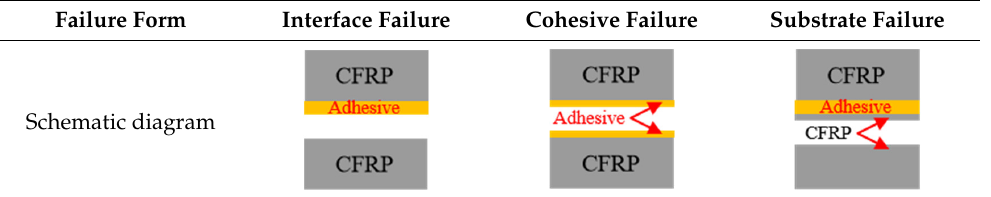
Table 7. Schematic diagram of failure types of single-lap joints.